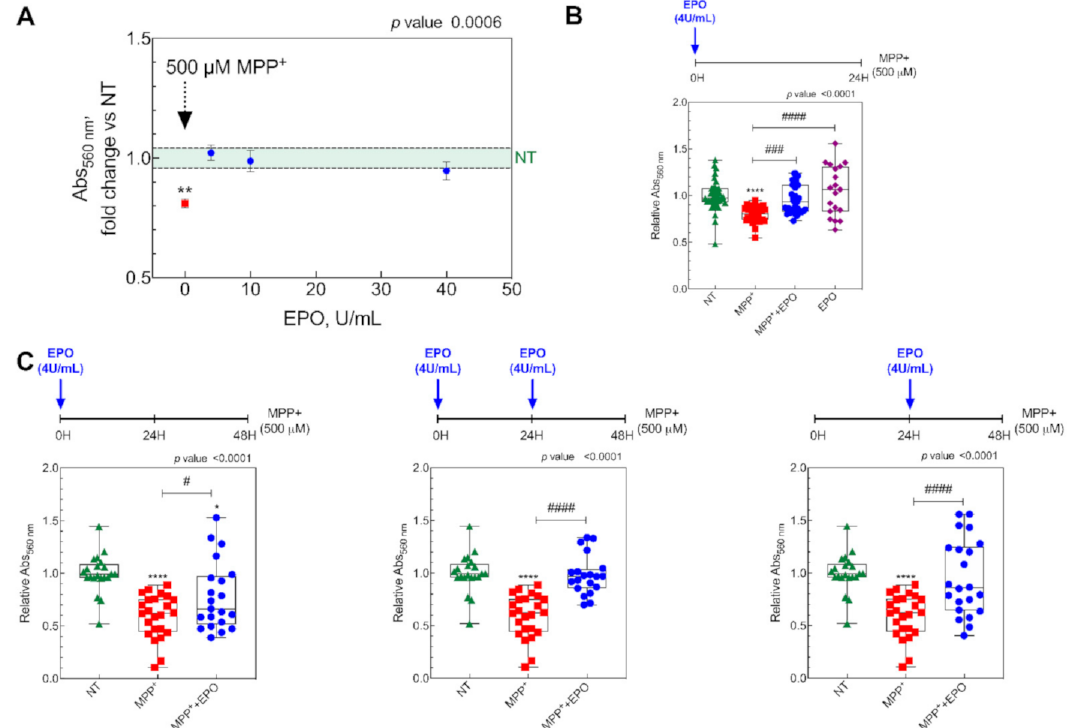
Figure 1. In vitro results showing the effect of erythropoietin (EPO) on cell viability. ( A ) Cell viability in SH-SY5Y cells treated with 500 µ M MPP + (MPP + ), and MPP + plus 4, 10 and 40 U/mL EPO for 24 h. Data are expressed as mean ± SEM of 8 replicate values in 3 independent experiments ( n = 24) and results are represented as percent of non-treated (NT), shown as the light green area. ** p < 0.01 vs. NT. ( B ) Cell viability in SH-SY5Y cells (NT), cells treated with 500 µ M MPP + (MPP + ), cells treated 500 µ M MPP + + EPO 4U/mL (MPP + + EPO) and cells treated with 4U/mL EPO (EPO). Data are expressed as box-and-whisker plot of 8 replicate values in 3 independent experiments ( n = 24). Data are represented as a fraction over non-treated (NT). **** p < 0.0001 vs. NT; ### p < 0.001, #### p < 0.0001 vs. MPP + . ( C ) Effect of 4U/mL EPO on cell viability during 48 h MPP + treatment. Viability was evaluated after 48 h in the three different experimental conditions in which EPO was administered at three different time points as reported in the timeline above each graph. Data are expressed as box-and-whisker plot of 8 replicate values in 3 independent experiments ( n = 24) and results are represented as fraction over NT values. * p < 0.05, **** p < 0.0001 vs. NT; # p < 0.05, #### p < 0.0001 vs. MPP +